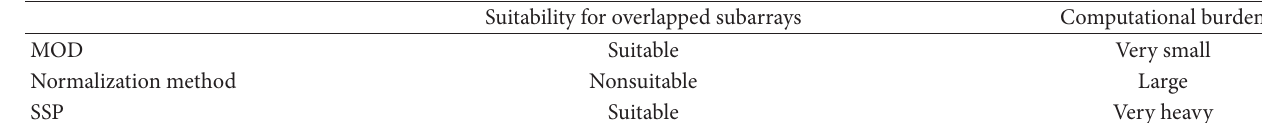
Table 1: Performance contrast of quiescent pattern control approaches.